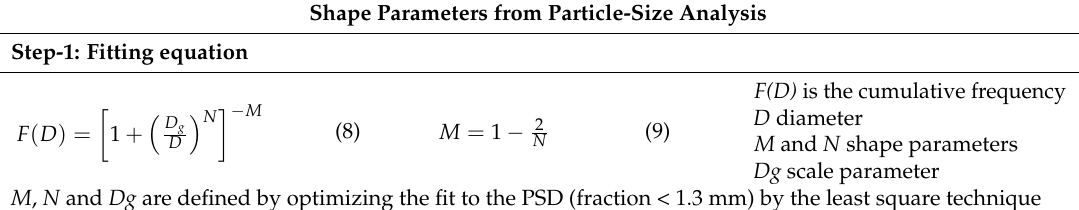
Table 1. Shape parameter estimation from particle size distribution